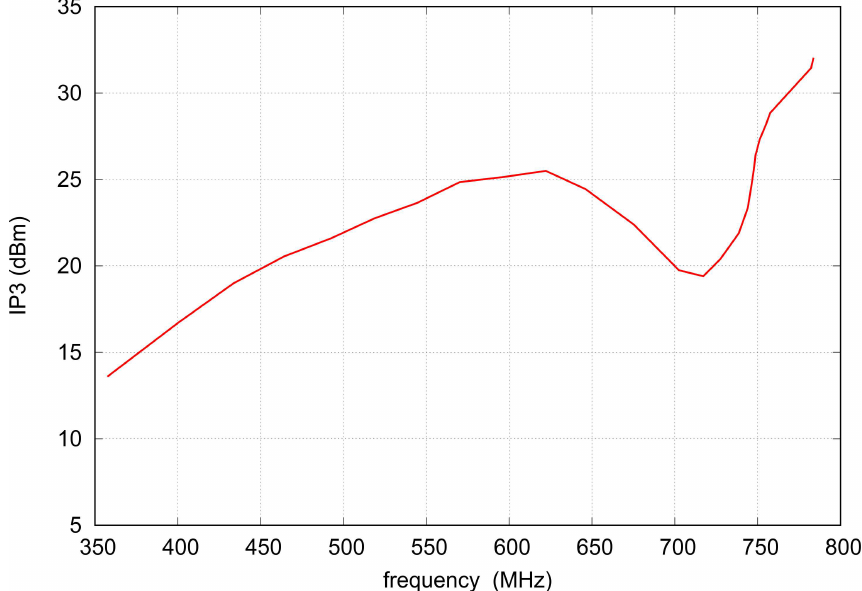
Figure 22. Measured IP3 versus filter center